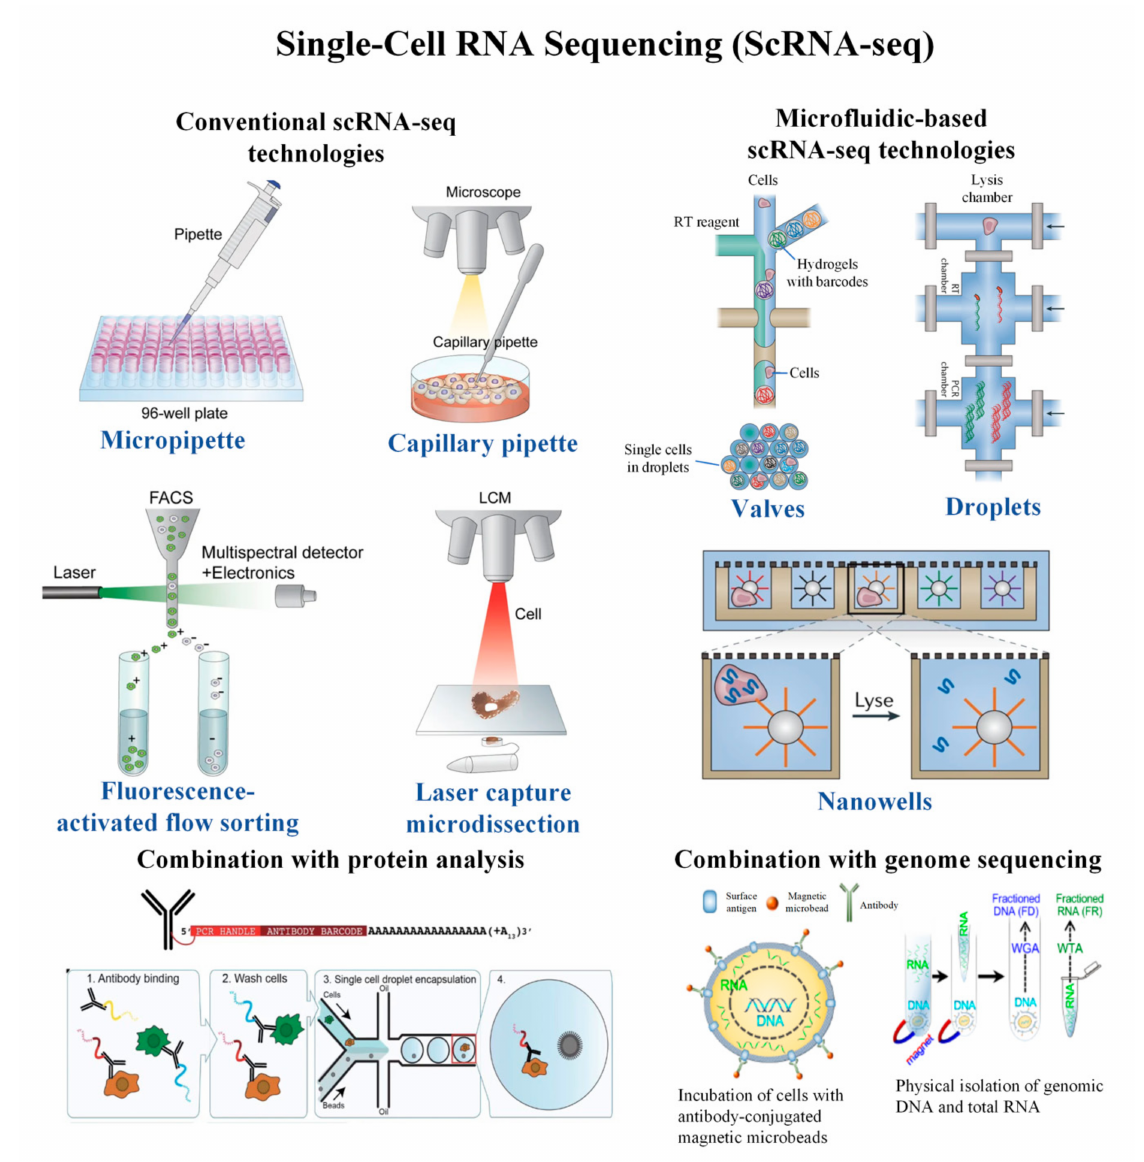
Figure 1. Schematic diagram of single-cell RNA sequencing and its combination with protein and DNA analyses. Conventional scRNA-seq involves isolation of cells using a micropipette, capillary pipette, fluorescence-activated cell sorting, or laser capture microdissection. Microfluidic-based